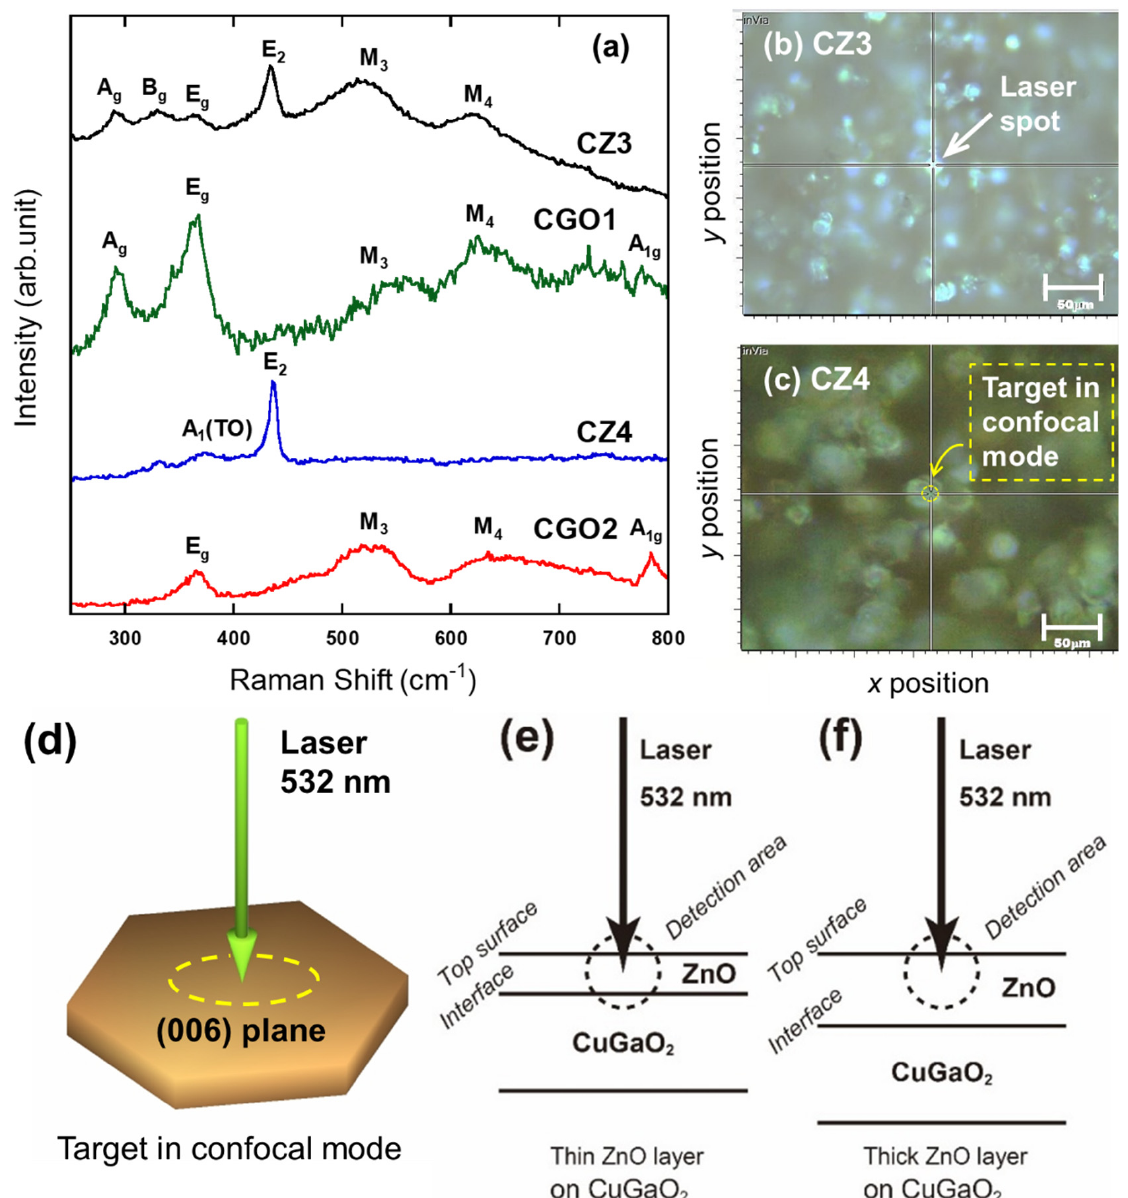
Figure 6. ( a ) Raman spectra of CuGaO 2 and CuGaO 2 /ZnO, and optical microscopy images of ( b ) CZ3 and ( c ) CZ4. The scale bar is 50 μ m. ( d ) Illustration of micro ‐ Raman experiment and ( e , f ) schematic drawings of depth region for the confocal Raman detection.